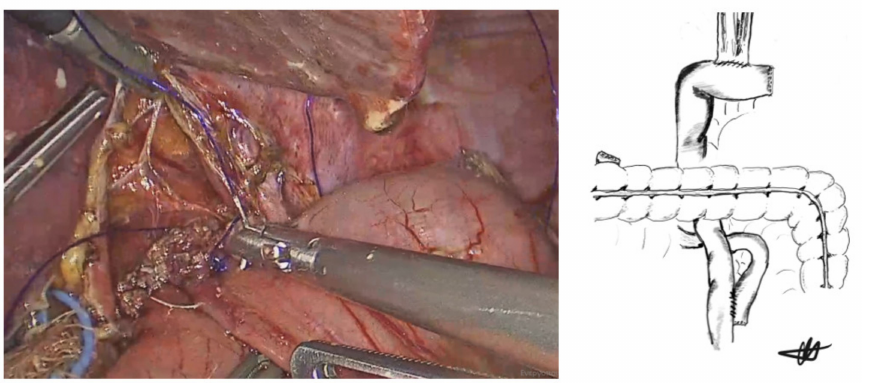
Figure 6. Anterior outer layer (Lembert sutures) and final view of the